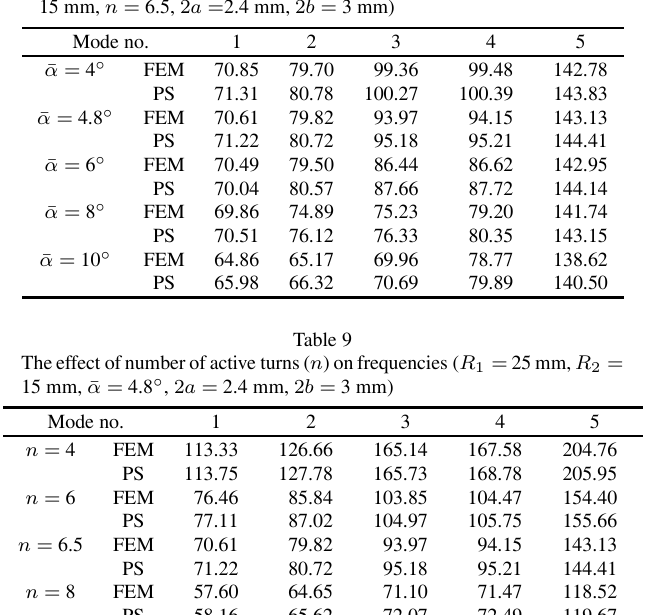
Table 8 The effect of helix angle (¯ α ) on frequencies ( R 1 = 25 mm, R 2 =